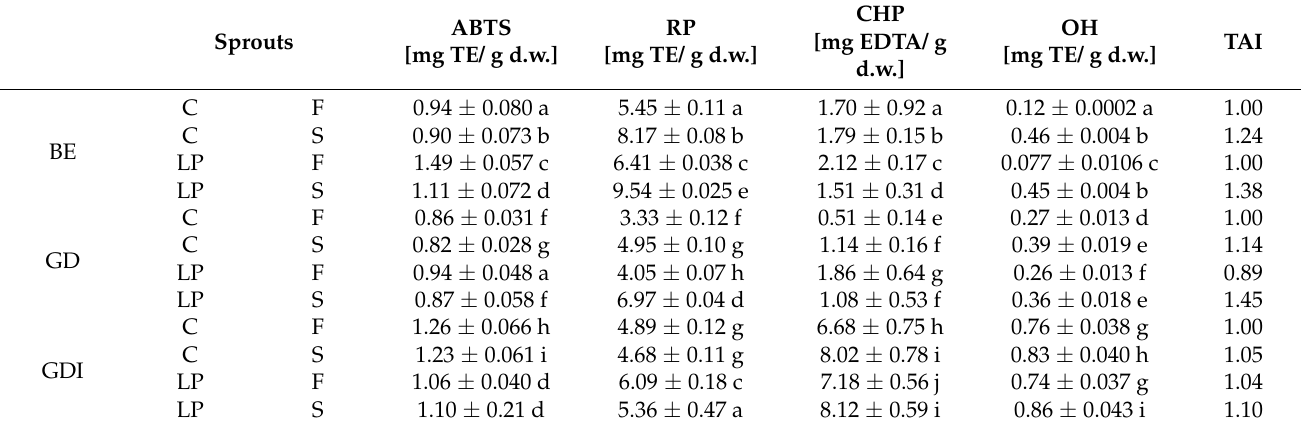
Table 4. Antioxidant capacity of phenolics from the stored control and probiotic-rich sprouts. ABTS Sprouts [mg TE/ g